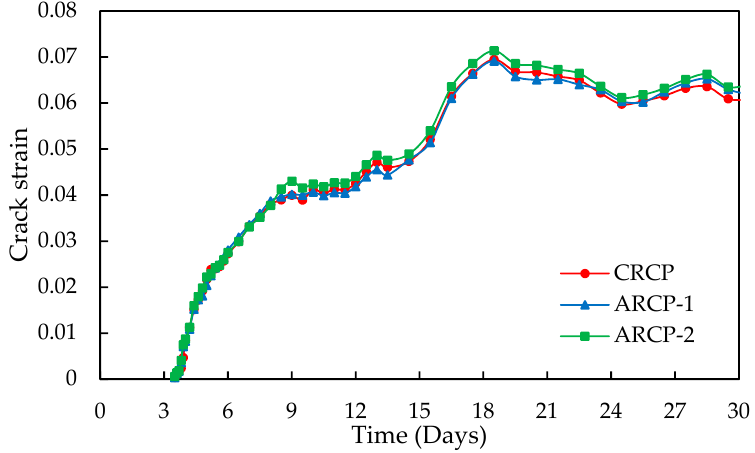
Figure 22. Comparison of crack strain over the saw-cut tips between CRCP and ARCP.